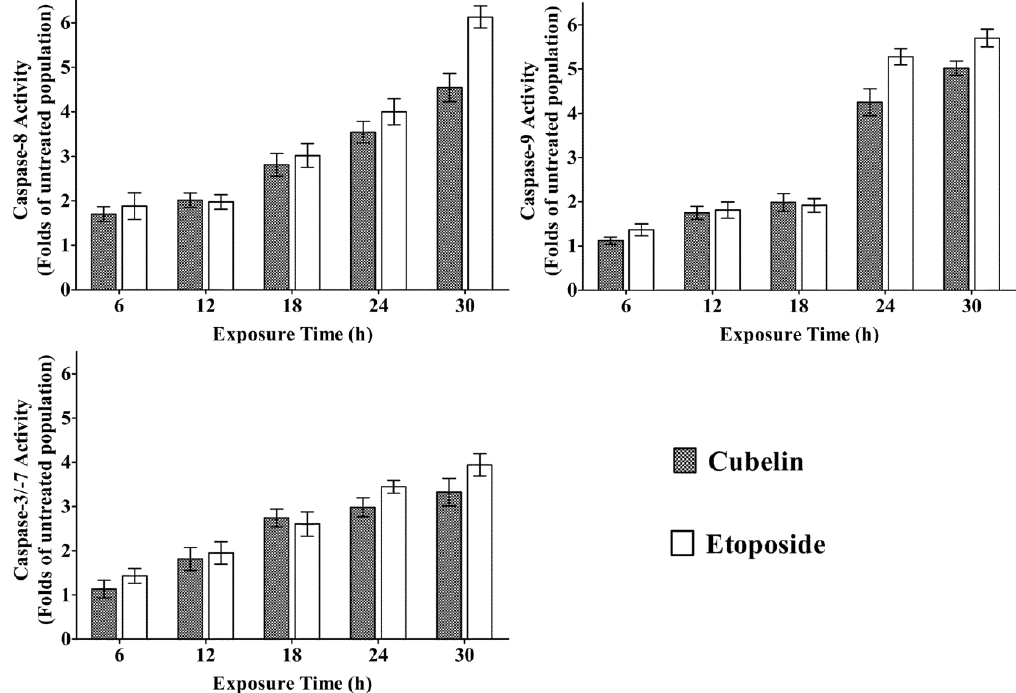
Figure 5. Effect of cubelin and etoposide (50 µM) on induction of HeLa cell apoptosis. Activity of caspase-8 ( A ), caspase-9 ( B ) and caspase-3/-7 ( C ) were measured and compared with that of the untreated